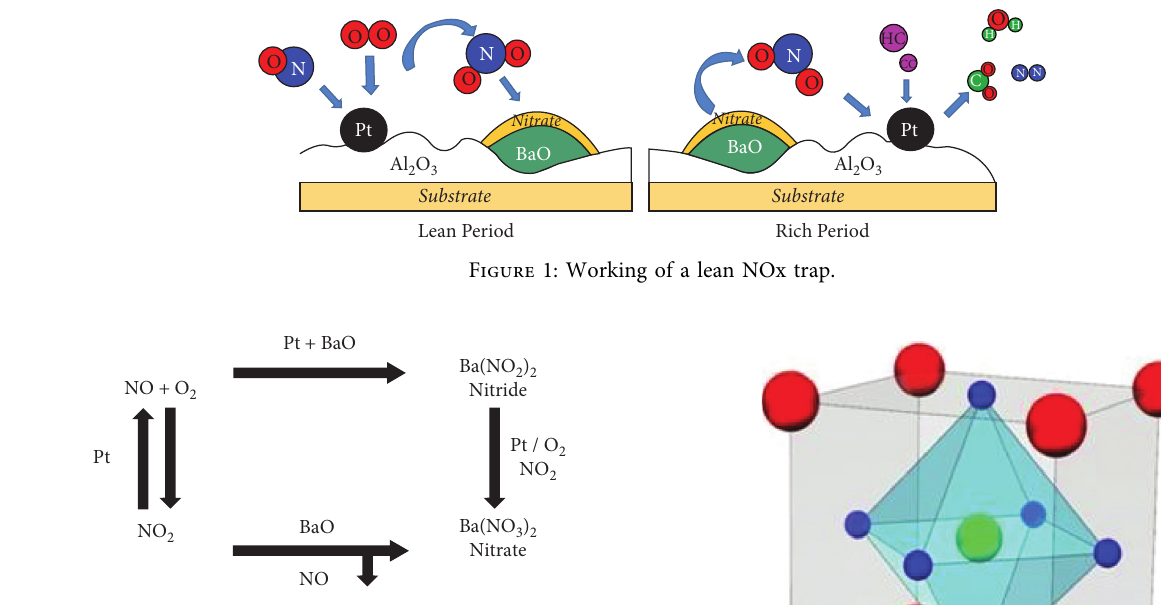
Figure 2: Nitrate & Nitrite formation in LNT.